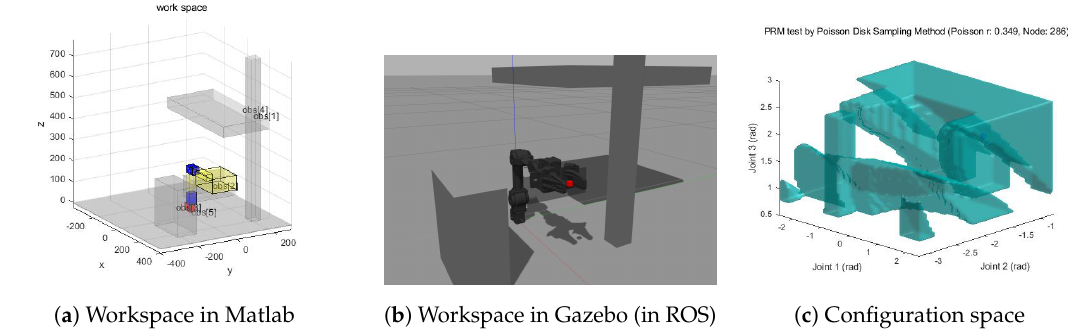
Figure 8. Workspace and configuration space. ( a ) Workspace in Matlab; ( b ) Workspace in Gazebo (in ROS); ( c ) Configuration